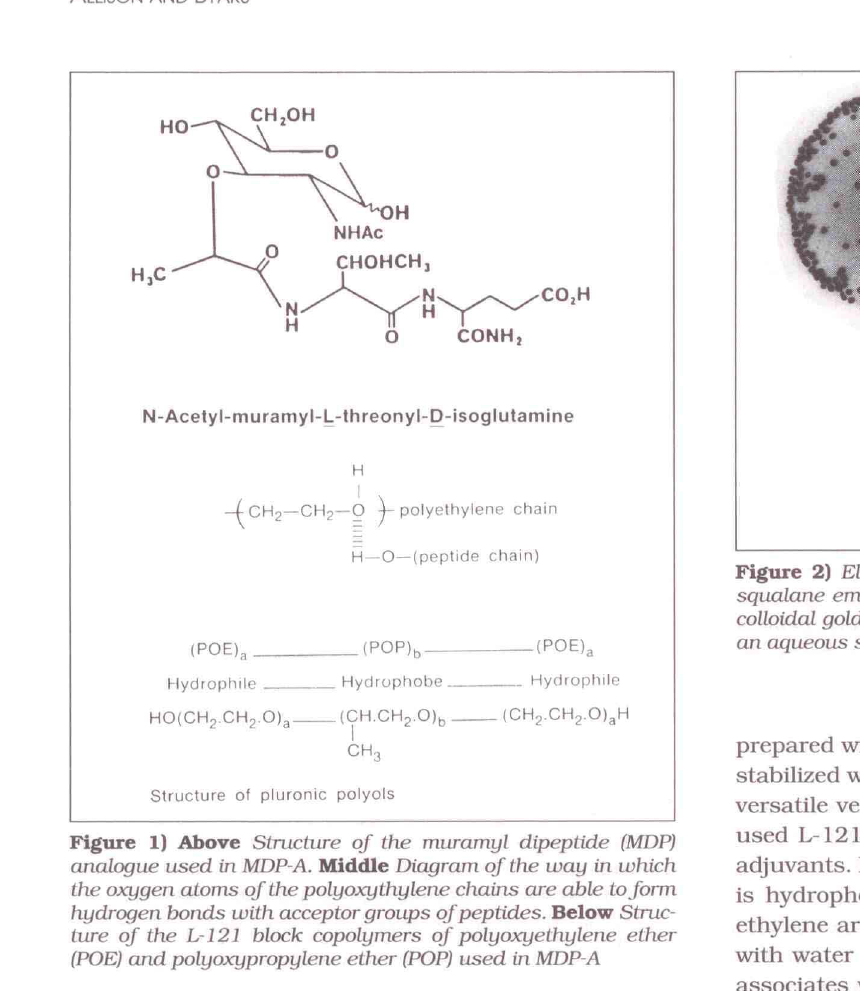
Figure 2) ELectron micrograph (x30,000) of a pLuronic L-121- squaLane emuLsion showing antigen (ovalbumin) labelLed